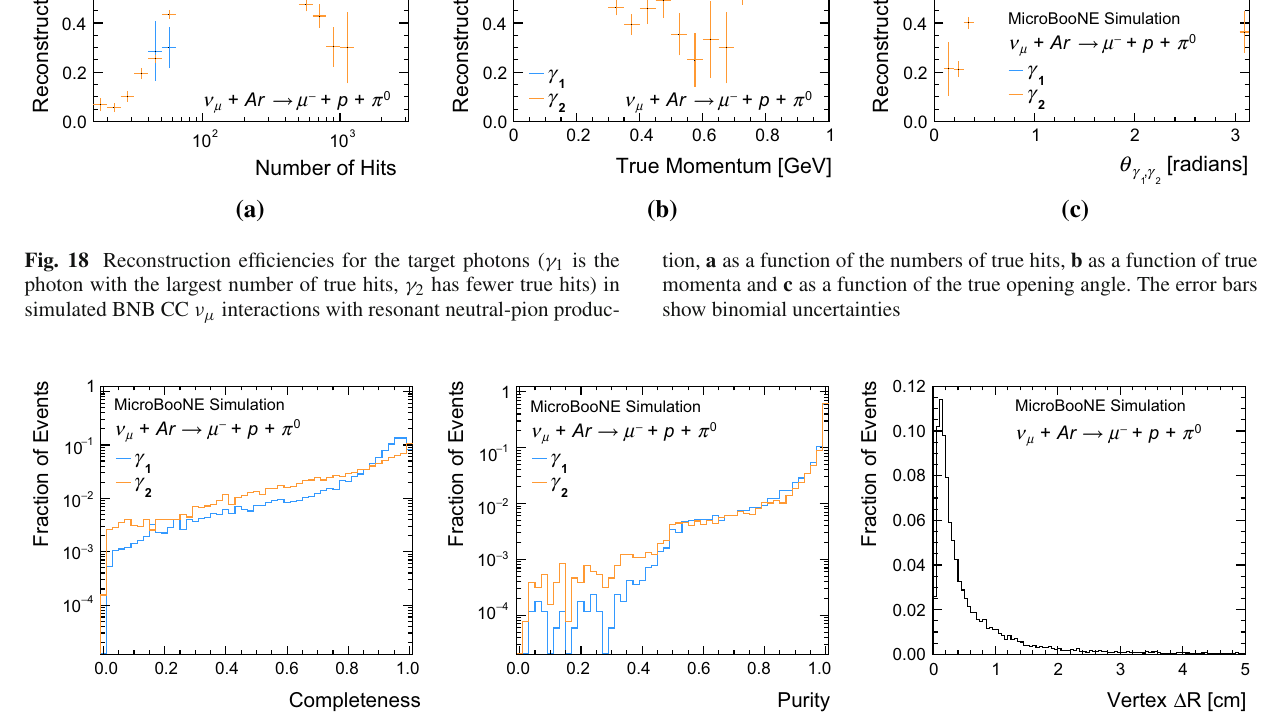
BNB CC ν μ interactions with resonant neutral-pion production and c the distance between generated and reconstructed 3D vertex positions